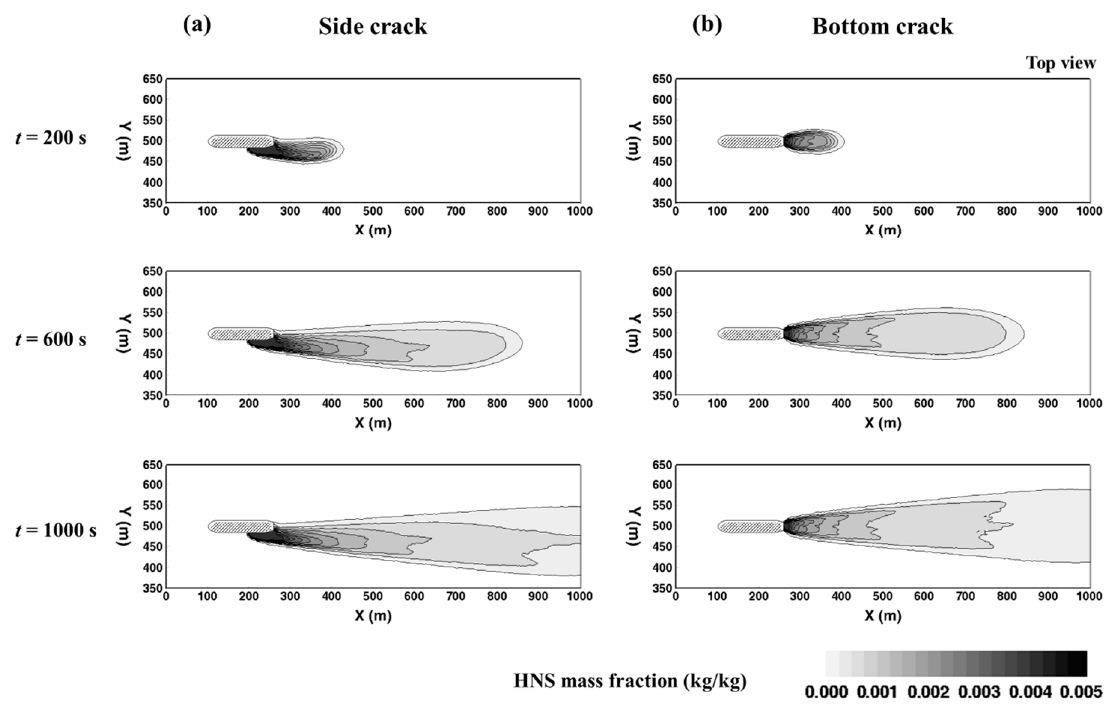
Figure 2. The transient evolution of hazardous and noxious substance (HNS) propagation: ( a ) Side crack and ( b ) bottom crack in the case that v c = 1.028 m/s and ρ hns = 800 kg/m 3 . crack and ( b ) bottom crack in the case that v c = 1.028 m / s and ρ hns = 800 kg / m 3